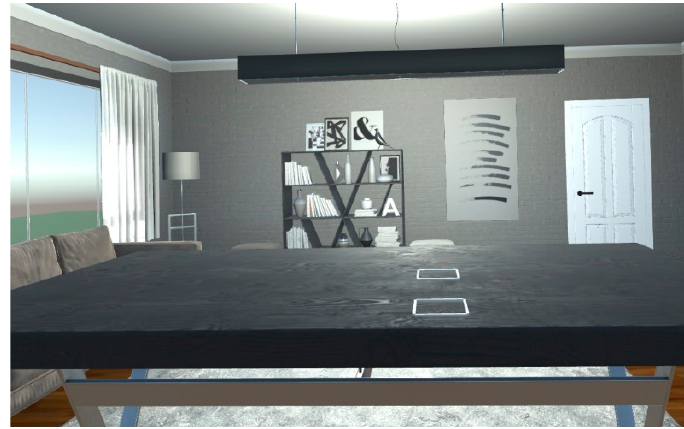
Figure 2. Virtual environment used for the application.